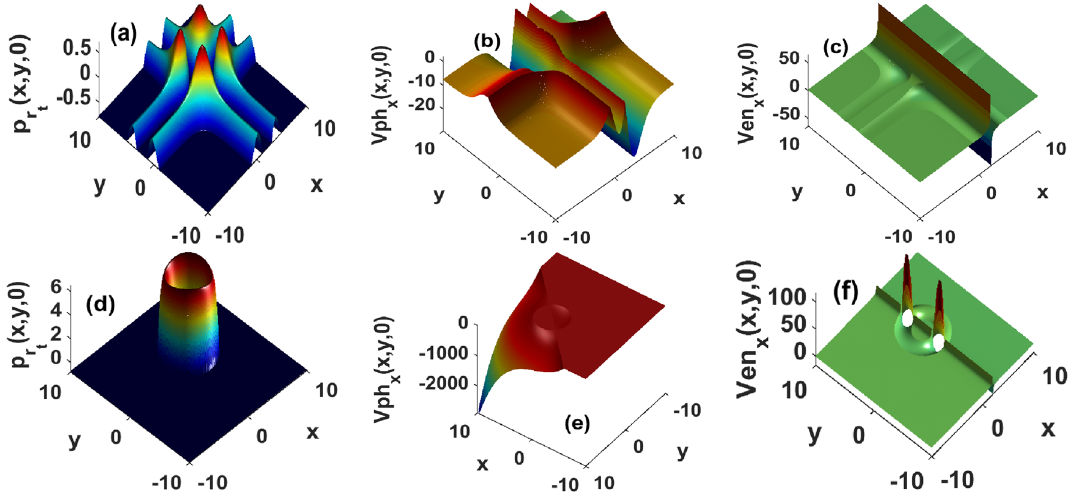
Figure 1. Growth rate, phase and envelope speeds of the localized perturbations in absence of a background velocity field ( u = v = 0 ) D 2 = 1.62, σ x = σ y = 2, k x = k y = 0.05, x 0 = y 0 = 2, � = 2 · 10 − 3 . Top panels are obtained with the secant function, and bottom panels are related to the Gaussian